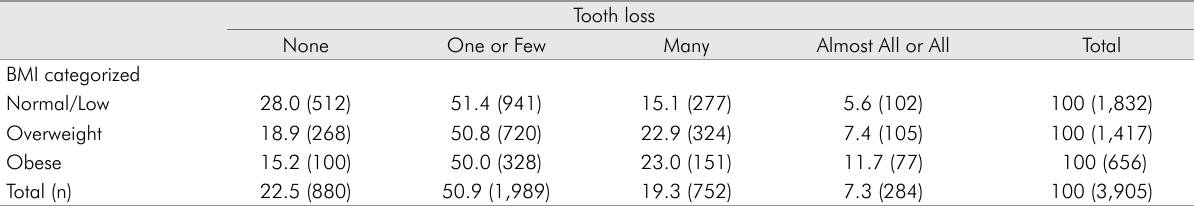
Table 1. Relative and absolute frequencies of BMI variable according to tooth loss category